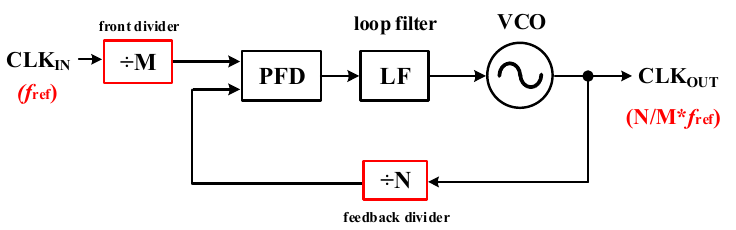
Figure 1. Block diagram of a general integer ‐ N PLL.